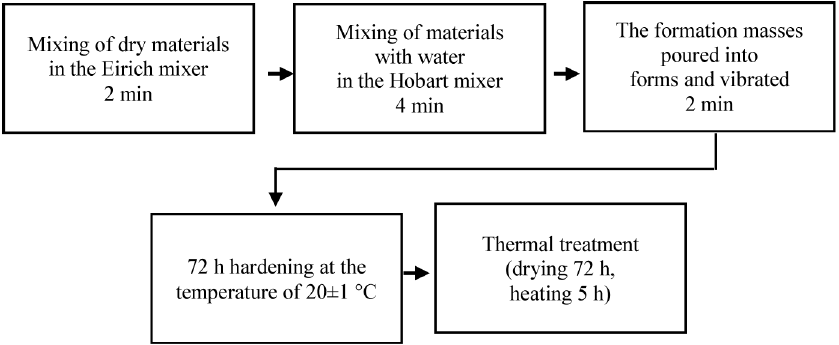
Fig. 2. The principal technological scheme for the preparation, hardening and thermal processing of refractory castable